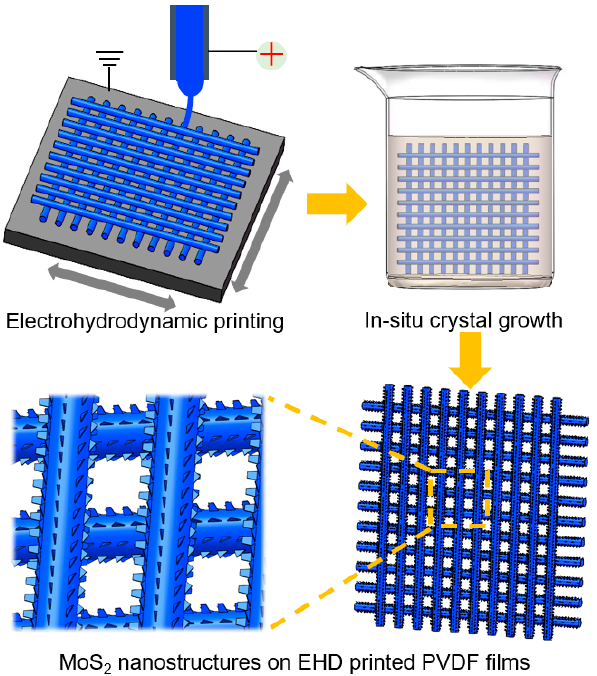
Figure 1. The fabrication process of the MoS 2 -PVDF composite film.